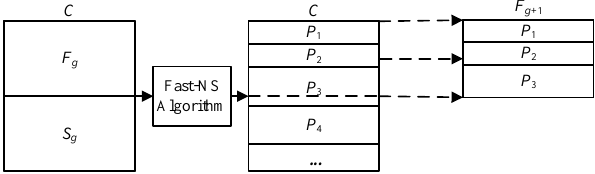
Figure 5. Selection strategy of elite individuals in the population.